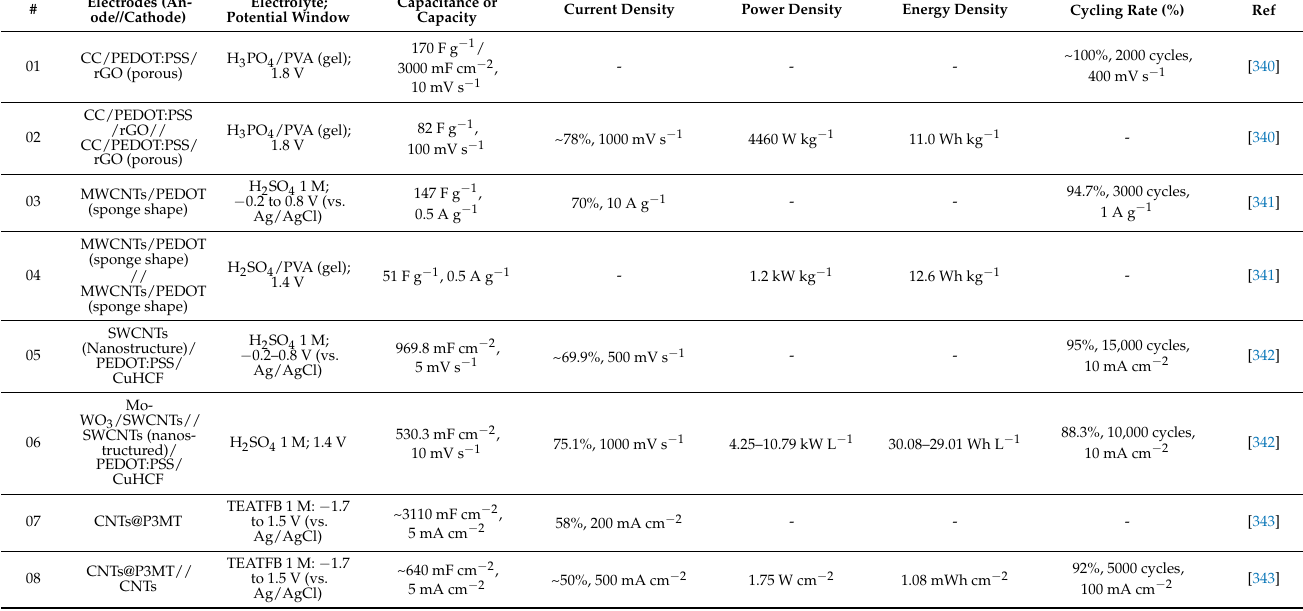
Table 4. PEDOT and other nanostructured PTh derivatives, in various configurations were evaluated for supercapacitor electrodes with their performance